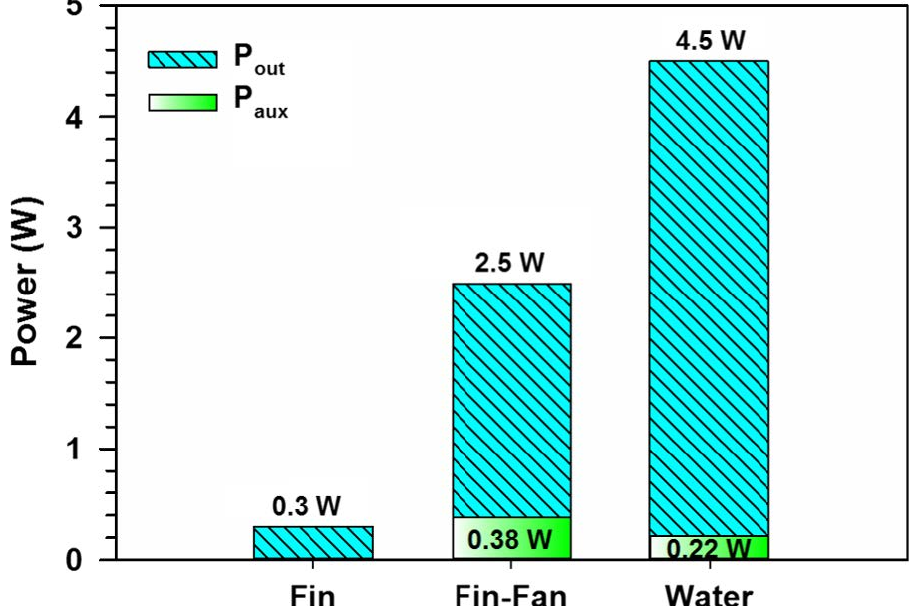
Figure 11. Net output power of the three different heat removal concepts. Reprint with permission [70]; Copyright 2021, Elsevier.